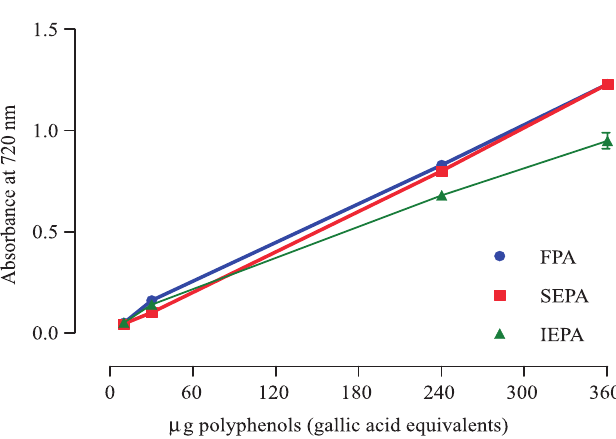
FIGURE 1 - Reducing capacity of polar fractions of Halimeda incrassata. Reducing power of the polar fractions was evaluated at concentrations of 10 - 360 µg polyphenols and the assay was performed according to Oyaizu et al. , (1986). Values expressed as mean ± s.d. (n=3).